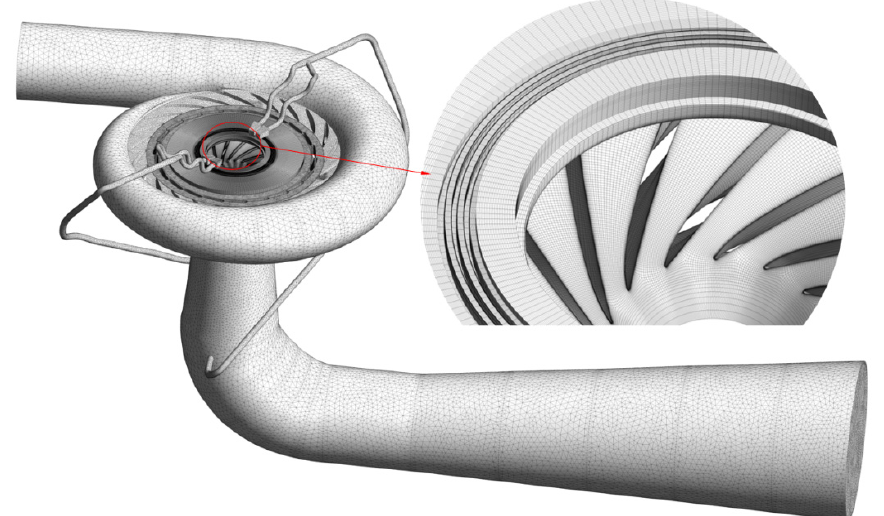
Figure 3. Finite volume mesh of the entire flow field of the PT unit.